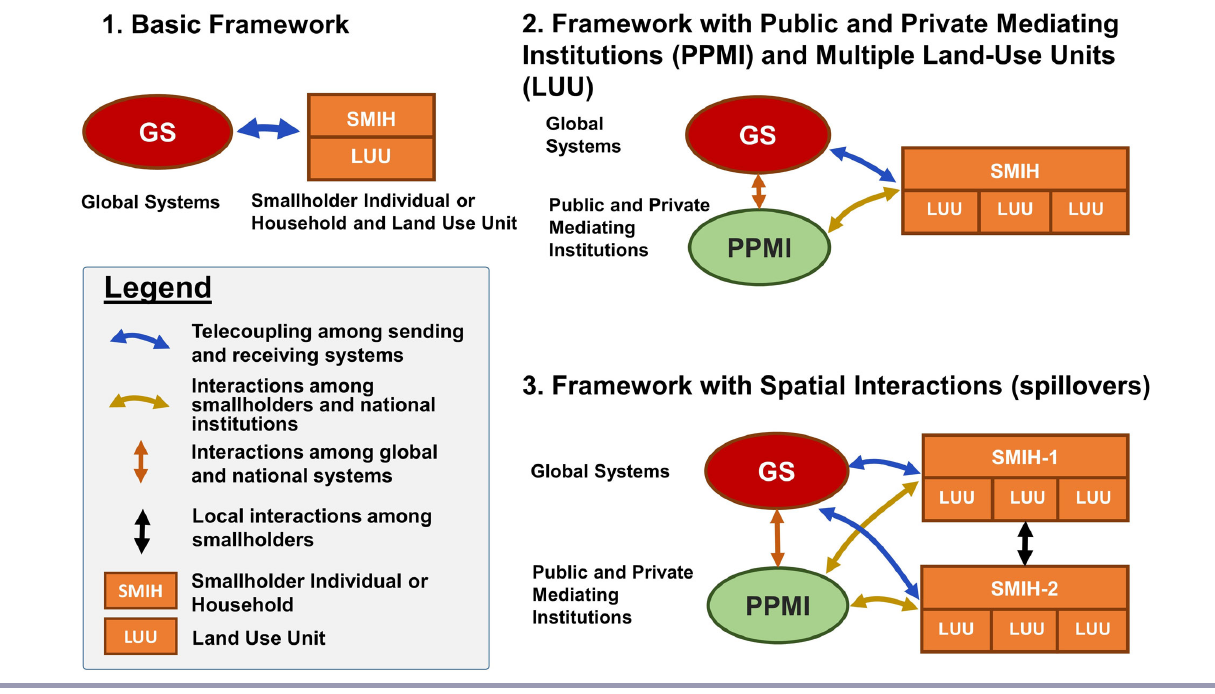
Fig. 5 . The conceptual framework of multilevel smallholder